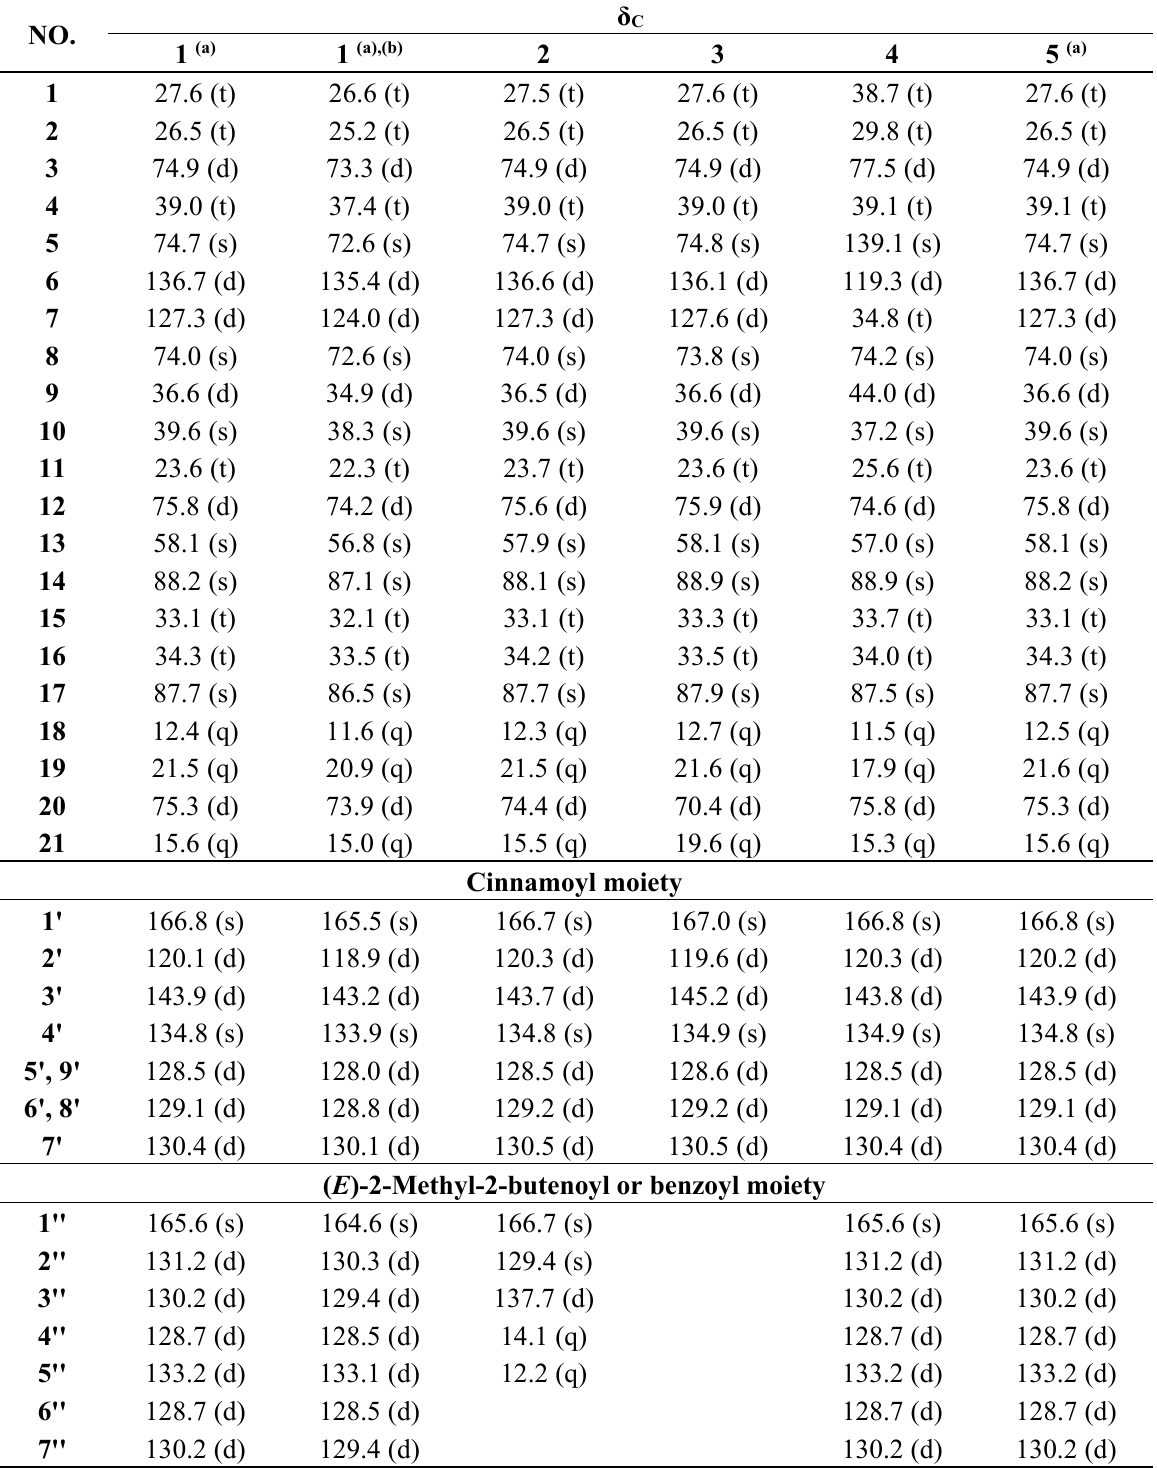
Table 2. 13 C-NMR (100 MHz) of the aglycones of compounds 1 – 5 (in pyridine -d 5 ).